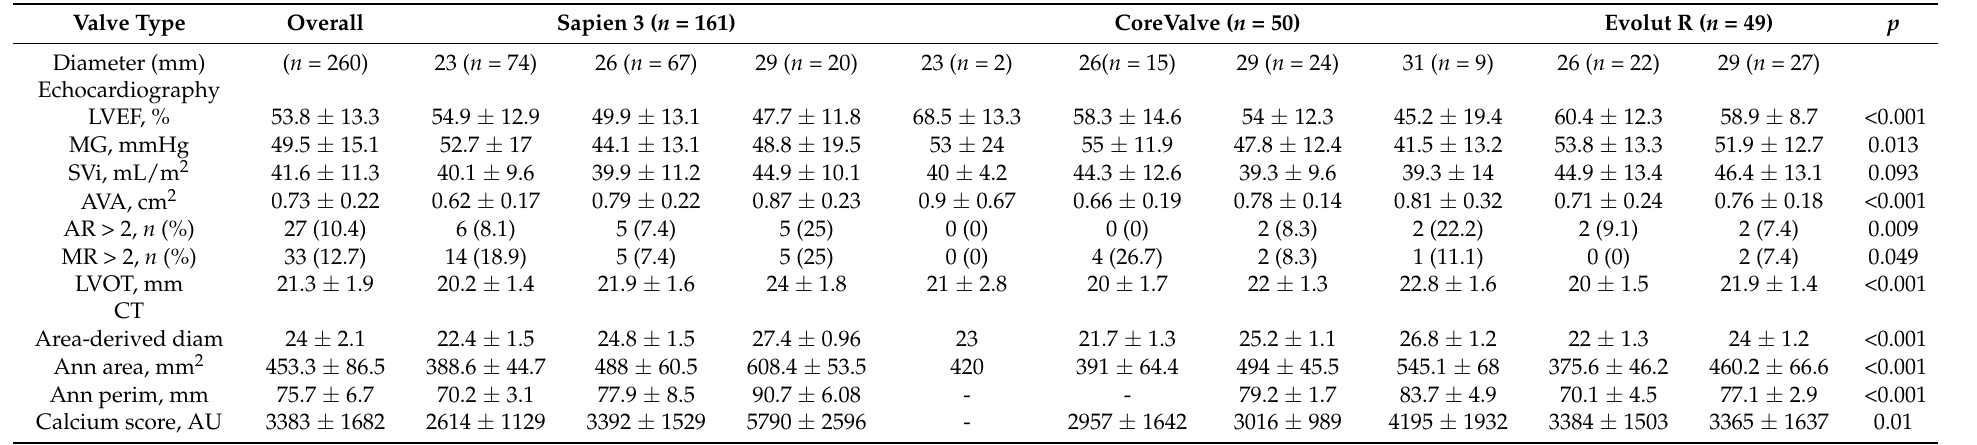
Table 2. Baseline characteristics of the study patients ( n =